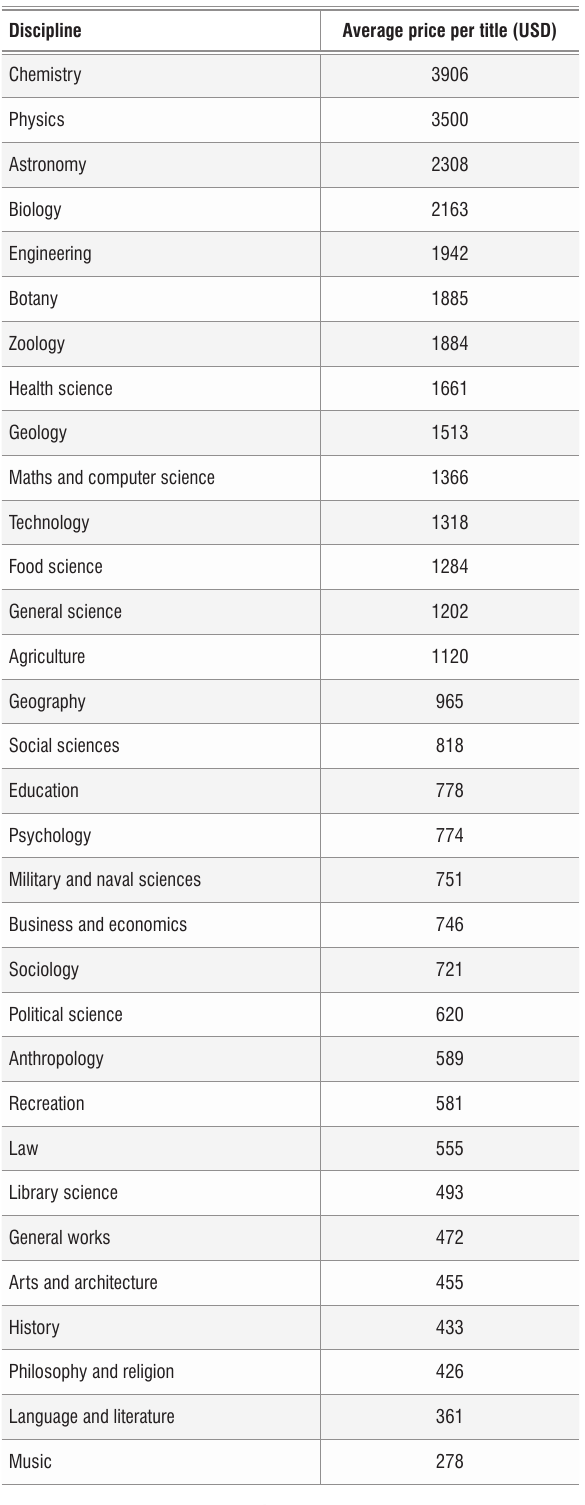
this is reflected in their prices: for-profit journals are priced 10–15 times higher than not-for-profit publisher titles. 7 Table 1: The average 2013 price † (per title) for online journals in the Web of Science index